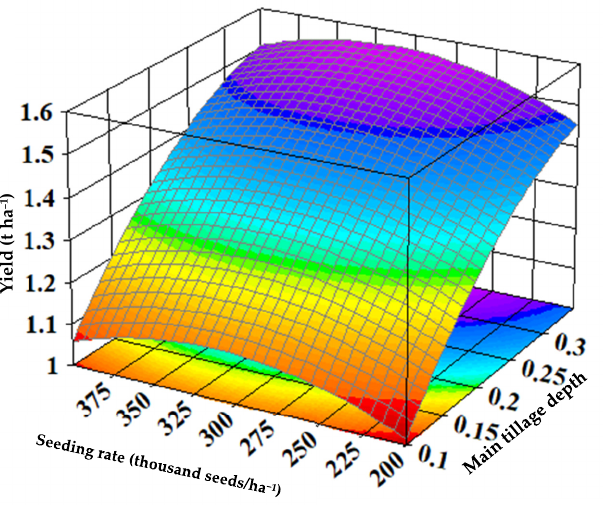
Figure 2. Response surface graph for the dependence of the yield of Kamyshinsky 73 safflower cultivar on seeding rate and tillage treatment.